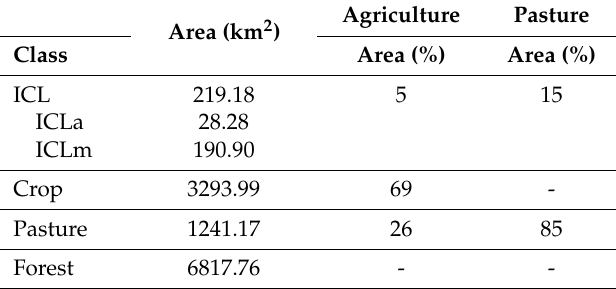
Table 8. Classification area, percentage of total agricultural areas and percentage of pasture